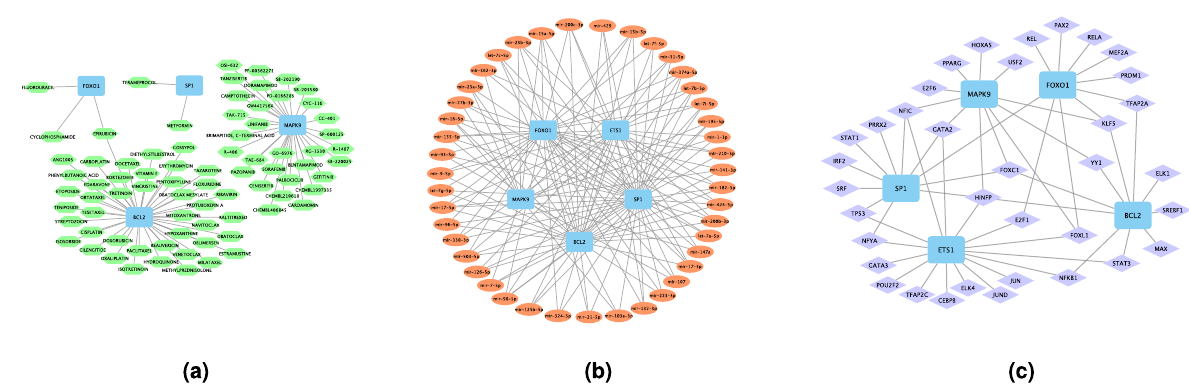
Figure 16. ( a ) Small-molecule drugs influencing hub gene expression or function. ( b ) MicroRNAs targeting hub genes. ( c ) Transcription factors regulating hub gene